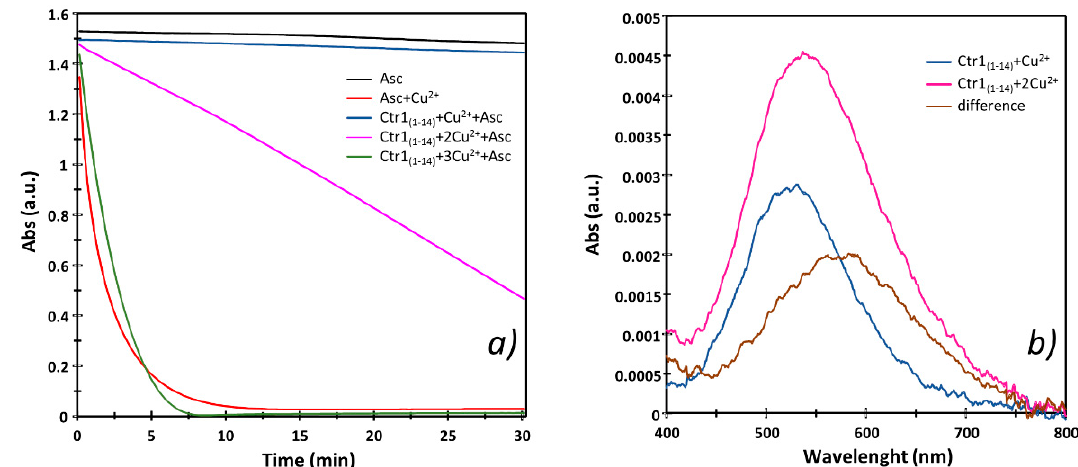
Figure 3. ( a ) Ascorbate-dependent reduction of Cu 2+ in the presence or absence of Ctr1 (1-14) at differ- ent metal/peptide ratios. Peptide (25 µ M) and ascorbate (100 µ M) solutions in MOPS (10 mM) at pH 7.2 were monitored for 30 min by UV-vis spectra at 265 nm. Change of ascorbate absorbance band: ascorbate without (black line) and with Cu 2+ (red line), 1:1 Cu 2+ /Ctr1 (1-14) ratio (blue), 2:1 Cu 2+ /Ctr1 (1-14) ratio (magenta), 3:1 Cu 2+ /Ctr1 (1-14) ratio (green). ( b ) UV-vis spectra of Cu 2+ -Ctr1 (1-14) system carried out in the same experimental condition of Cu 2+ ascorbate-dependent reduction; the brown line represents the difference spectra.